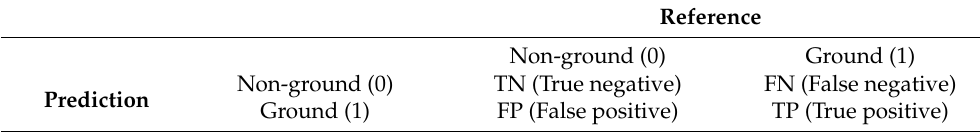
Table A2. Confusion